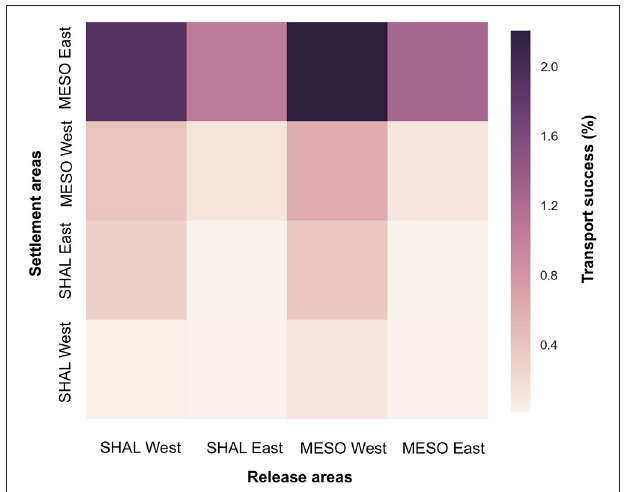
FIGURE 5 | Connectivity matrices representing the mean percentage of vertical transport success of M. cavernosa larvae between shallow (18–30m depth for West FGB and 16–30m depth for East FGB) and mesophotic (30–112m depth for West FGB and 30–110m depth for East FGB) reefs in the West and East FGB for the 3 years of simulation (2013, 2014, and 2015). SHAL, shallow; MESO, mesophotic.